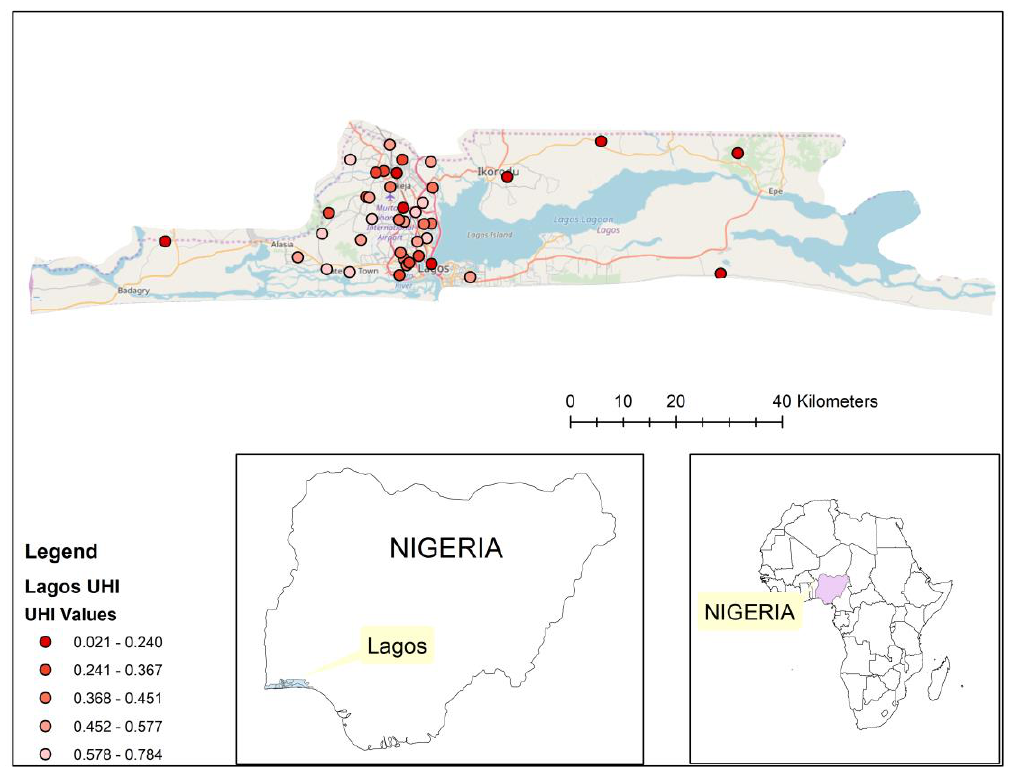
Figure 6. Distribution of DHS clusters and cluster UHI-9 score for Lagos, Nigeria.